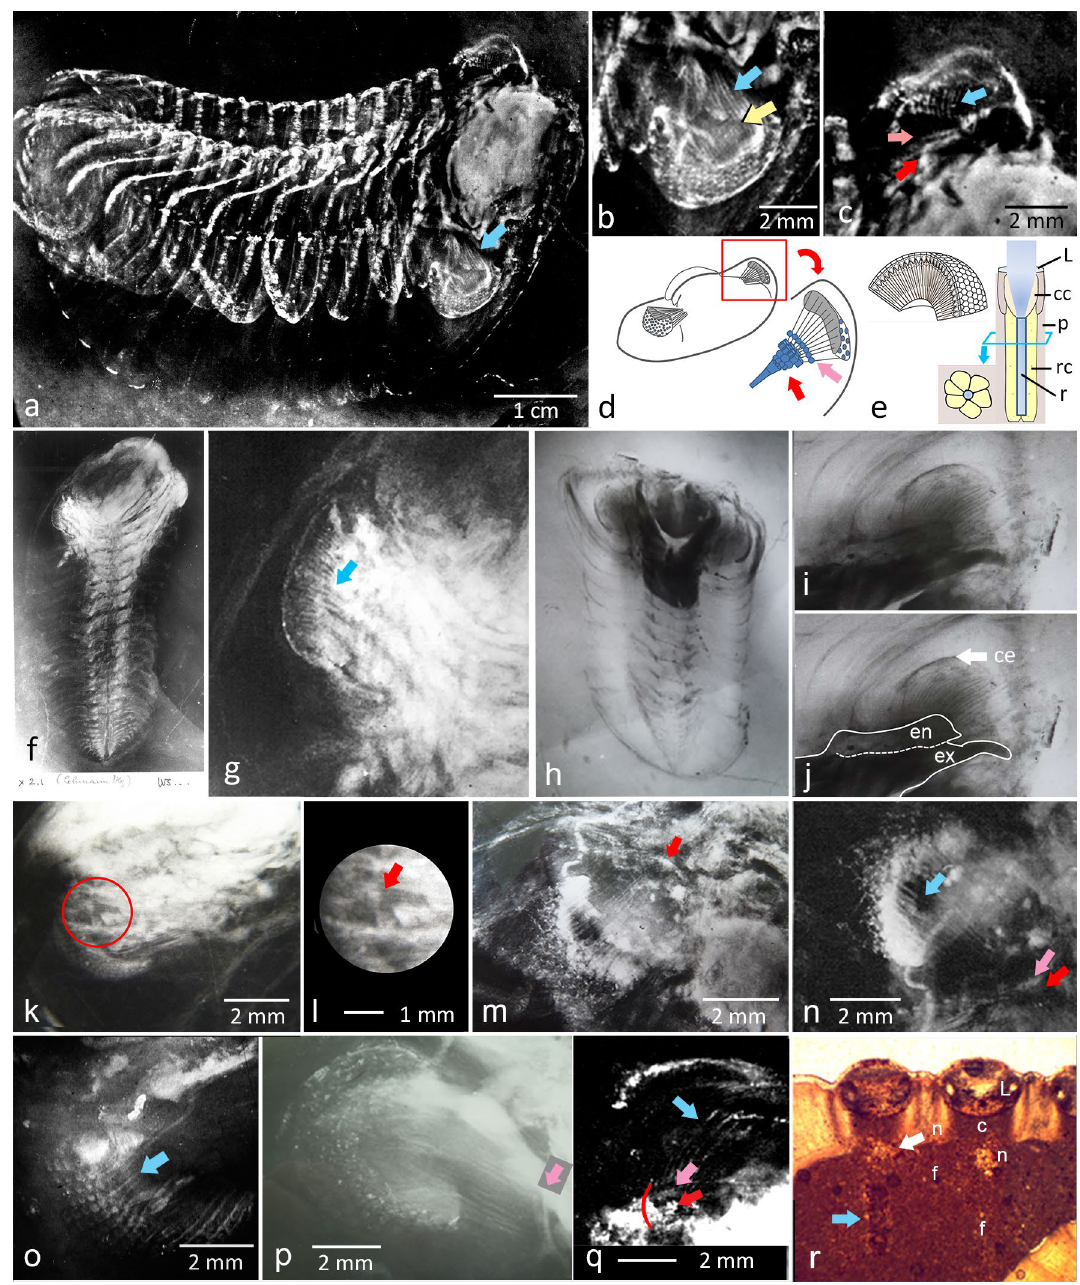
Figure 1. Filaments at the visual units of phacopid trilobites. ( a ) Chotecops ( Phacops ) ferdinandi (Kayser, 1880), [WS 2617]. ( b ) Right eye of a. ‘ fibers ’ originating below the facets, converging towards interior of the cephalon. ( c ) Left eye of a, with (indistinct) ‘ fibers ’, converging to plate of spheres and pyramidal element. ( d ) Schematic drawing of ‘ fibers ’. ( e ) typical ommatidium (apposition eye). ( f ) Lehmann’s specimen of Asteropyge 6 ( Rhenops ) sp., [WS 2882]. ( g ) Left eye of f, showing ‘ fibers ’. h) C. ferdinandi , [WS 822]. ( i ) Appendage with gill-filaments, tapering distally. ( j ) i with endopodite (en) and exopodite (ex) of the appendage explained. ( k ) Eye of C. ferdinandi , each ‘ fiber ’ connected to one visual unit [WS 4.1/503]. ( l ) Section of k, there as red circle. ( m ) Eye of C. ferdinandi [not numbered, XRCB], ‘ fibers ’ converging to a centre. ( n ) C. ferdinandi, ‘fibers ’, converging to a supposed neuropile, [WS 295]. ( o ) C. ferdinandi, 1:1 relation between visual units; [WS 609(3)]. ( p ) C. ferdinandi , indistinct ‘ fibers ’, converging to pyramidal element [WS 1832]. ( q ) C. ferdinandi , indistinct ‘ fibers ’, converging to plate of spheres and pyramidal element [WS 1832]. ( r ) Thin-section of the eye of Phacops tafilatelensis Alberti 1983, showing lens, capsule that contains the receptors, foamy structure below (supposed neuropil), and ‘ fibers ’, c capsule containing receptor cells, cc crystalline cone, ce compound eye, f ‘ fiber ’, L lens, n neuropile, rc receptor cells, r rhabdom, ( g – k ) no scales given. XRCB Stürmer’s x-radiographs in the Steinmann Institute, Bonn. blue arrows: ‘ fibers ’; red arrows: pyramidal element; yellow arrow: underlying appendage; pink arrows: neural plate; white arrow: neuropil. Figure 1a–c are taken from Stürmer et al. 22, pl. iV, Fig 15a and Fig. 1 c,n from Stürmer and Bergström 7, plate 21b,c